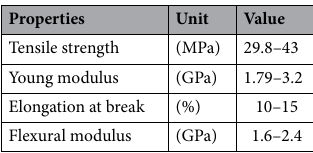
Table 1. Mechanical Properties of